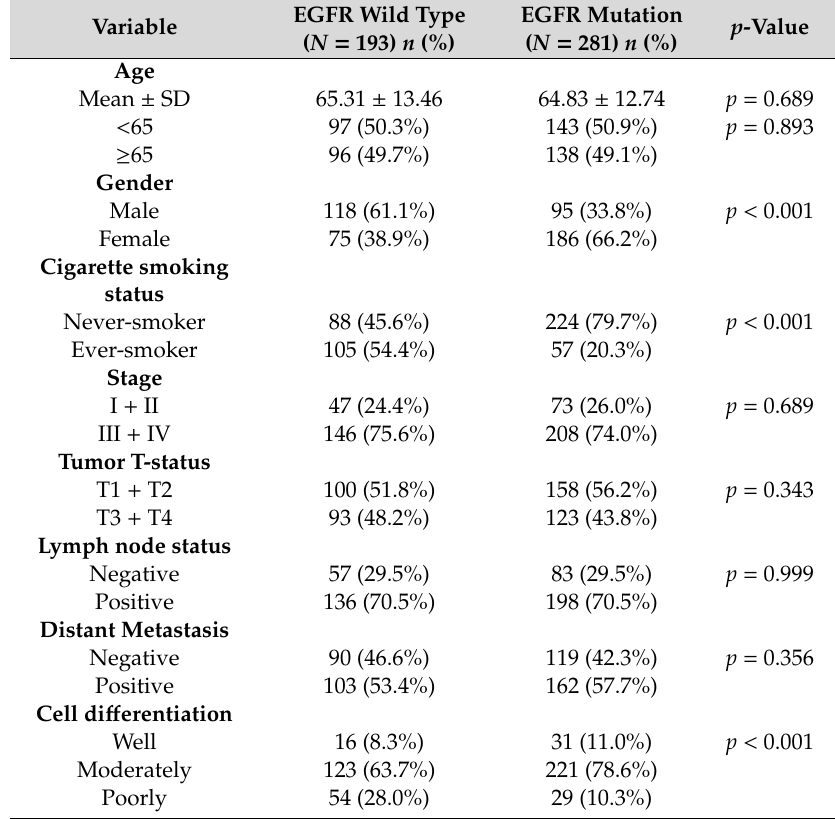
Table 1. Demographics and clinical characteristics of 474 patients in lung adenocarcinoma with epidermal growth factor receptor mutation